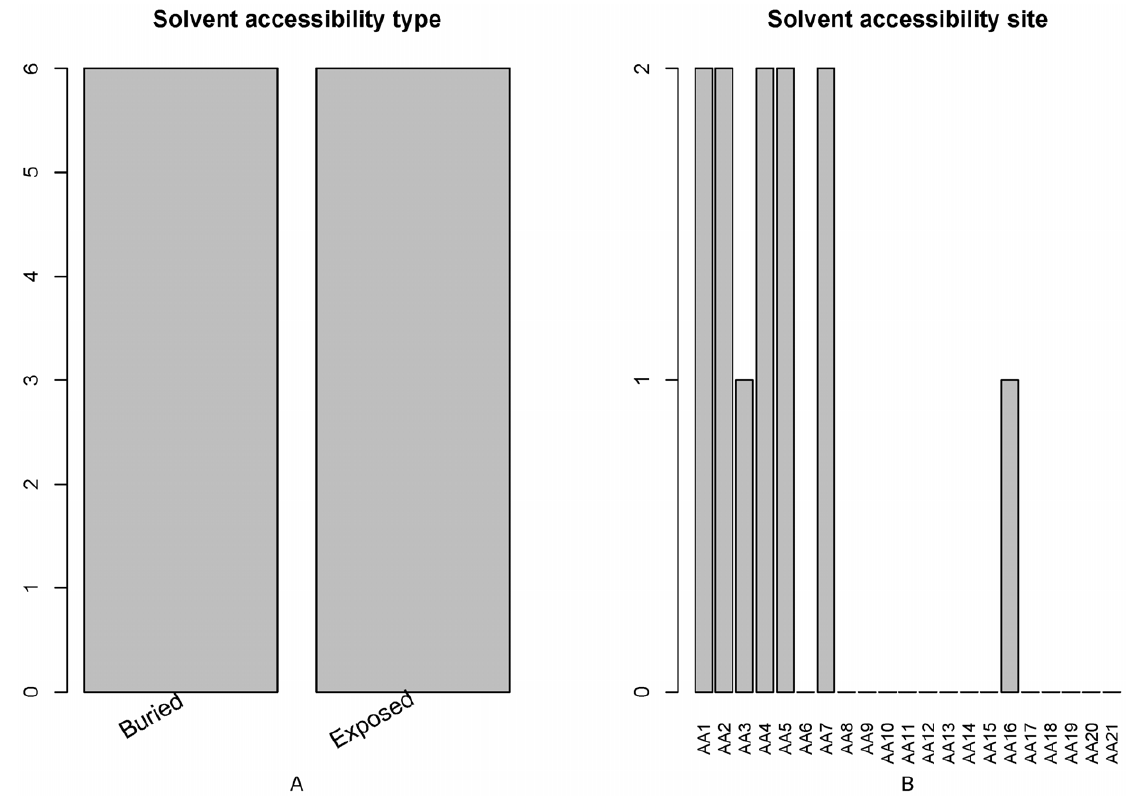
Figure 6. Feature and site specific distribution of the solvent accessibility features in the optimal feature set. (A) Feature distribution of the solvent accessibility features in the optimal feature set. The number of the two types of solvent accessibility features (buried and exposed) is equal (6), indicating that features derived from solvent accessibility are equally important for PCA site determination. (B) Site-specific distribution of the solvent accessibility features in the optimal feature set. Solvent accessibility features at site 1, 2, 4, 5, 7, 3 and 16 influences more on PCA site determination.